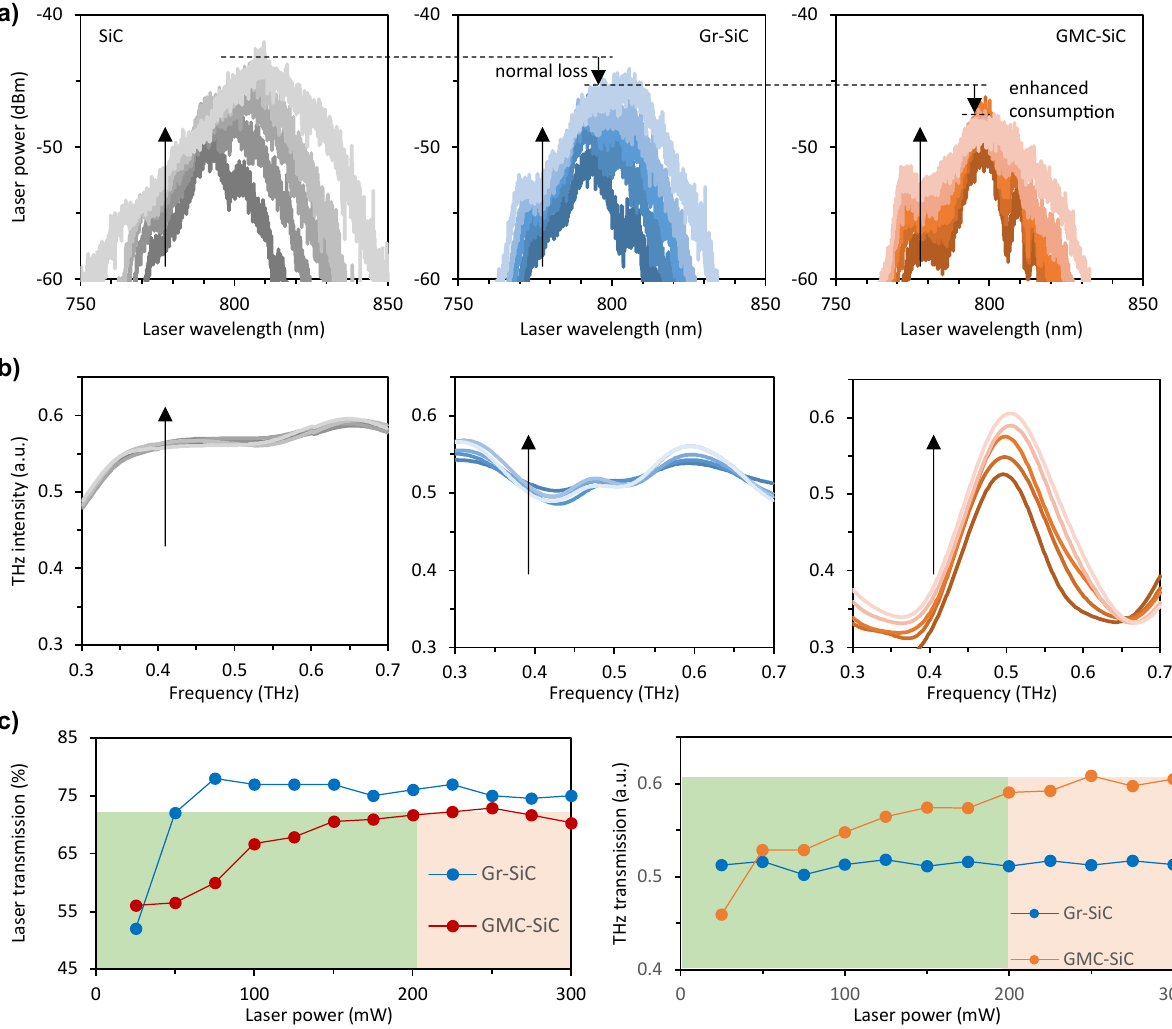
Figure 3: Nonlinearity transmission of SiC, Gr-SiC, and GMCs. (a) Detected laser transmission spectra of the SiC, the Gr-SiC, and the GMCs, all interacting with fixed input terahertz intensity (0.75 au). (b) Detected terahertz wave transmission spectra of the SiC, the Gr-SiC, and the GMCs, all interacting with fixed input terahertz intensity (0.75 au). In (a) and (b), black arrows demonstrate we rise the laser power from 50 mW to 250 mW, with gradient 50 mW per curve. (c) Summarized correlations of ‘laser power versus laser transmission’ and ‘laser power versus terahertz transmission (@0.5 THz)’. From 25 to 300 mW, graphene’s saturable absorption contributes to terahertz transmission enhancement in both the Gr-SiC and the GMCs. As reaching the saturable absorption threshold, GMCs owns higher pump consumption and terahertz enhancement than